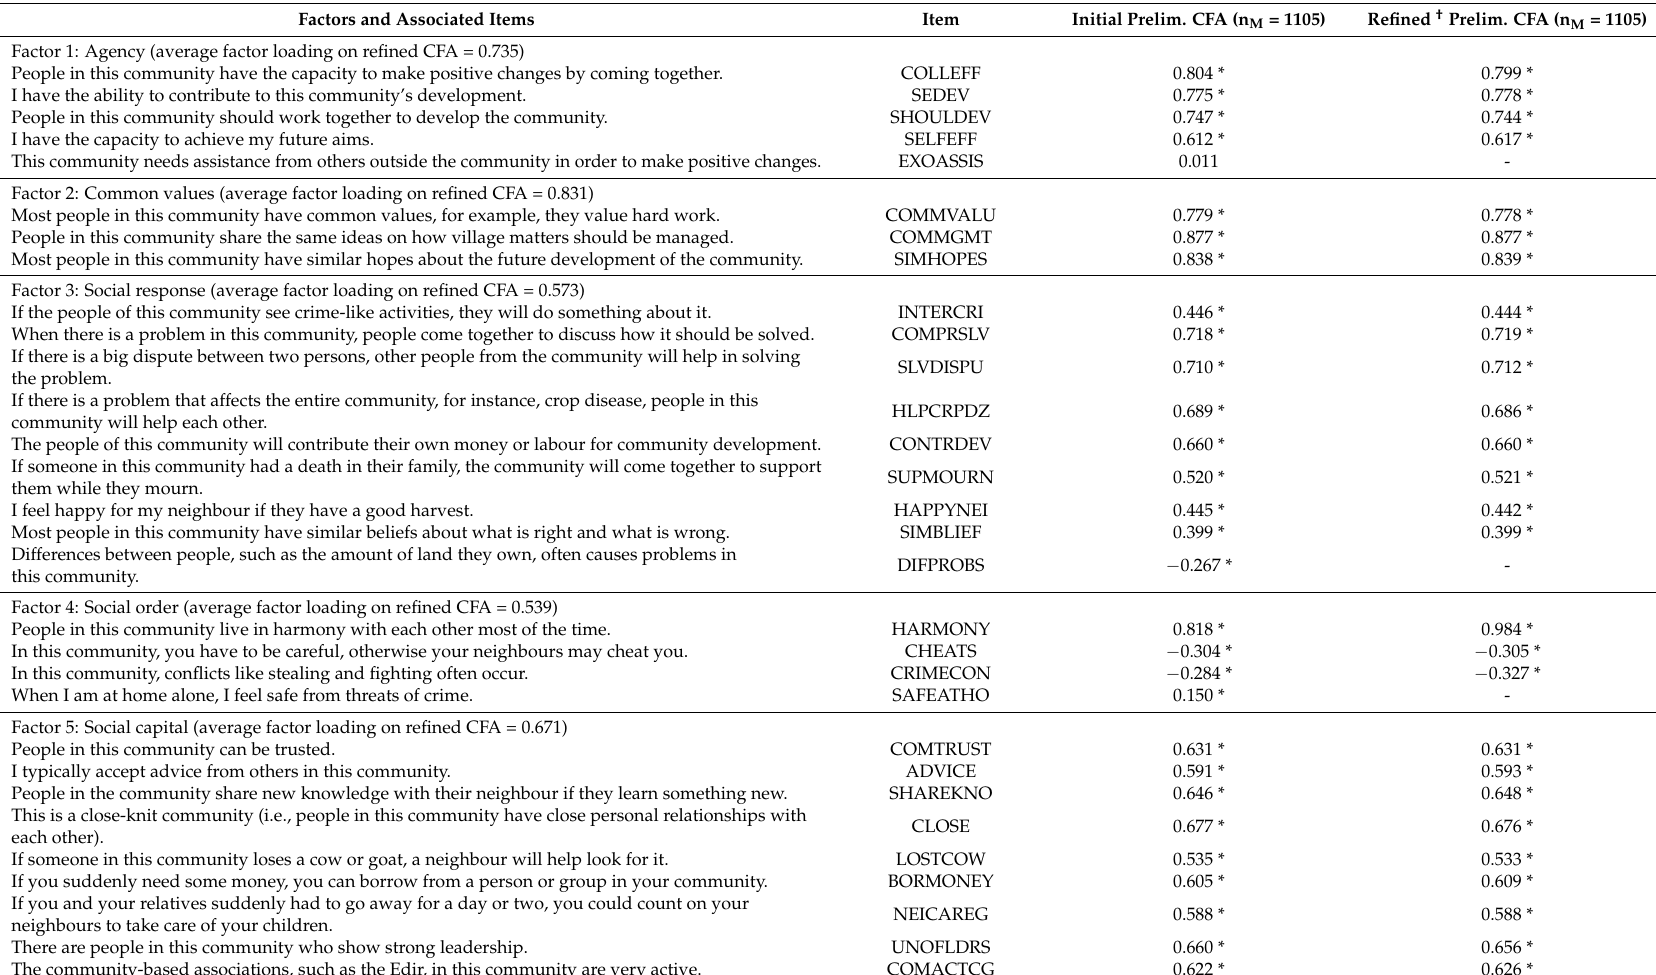
Table A2. Factor Loadings from Preliminary CFA of Our Hypothesised CE Framework,